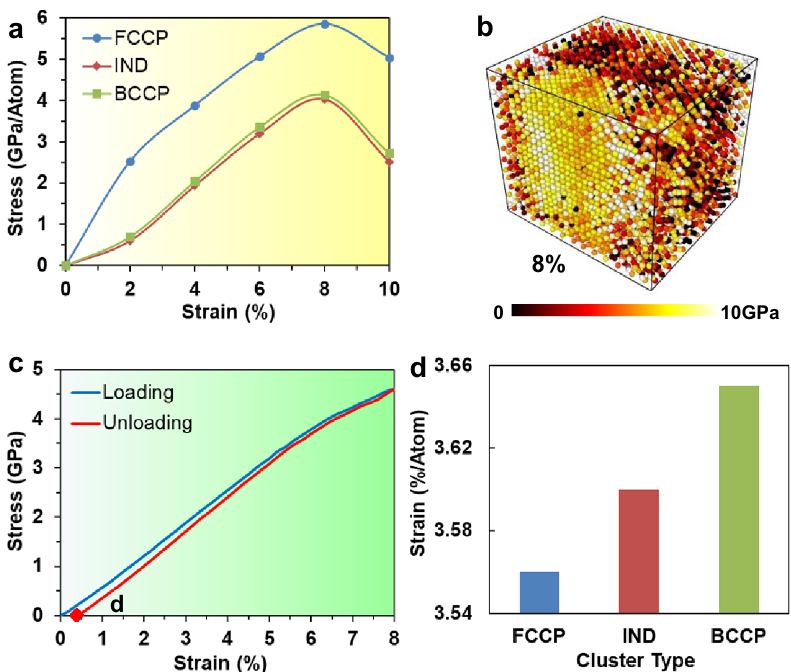
Fig. 5 Average stress, stress distribution, stress-strain curve, and average strain of the 2 M sample during loading and unloading processes at 300 K. a Variations of average normal stresses parallel to the tensile axis for atoms of different phase preference with strain in the 2 M sample during loading at 300 K. b Atomic con fi guration of the 2 M sample at a strain of 8% colored according to their stress distributions under 300 K loading. c Stress-strain curves of the 2 M sample during loading and unloading processes at 300 K. d Average atomic-level plastic strain parallel to the tensile axis for atoms of different phase preference in the 2 M sample after unloading to zero stress (marked in ( c )).